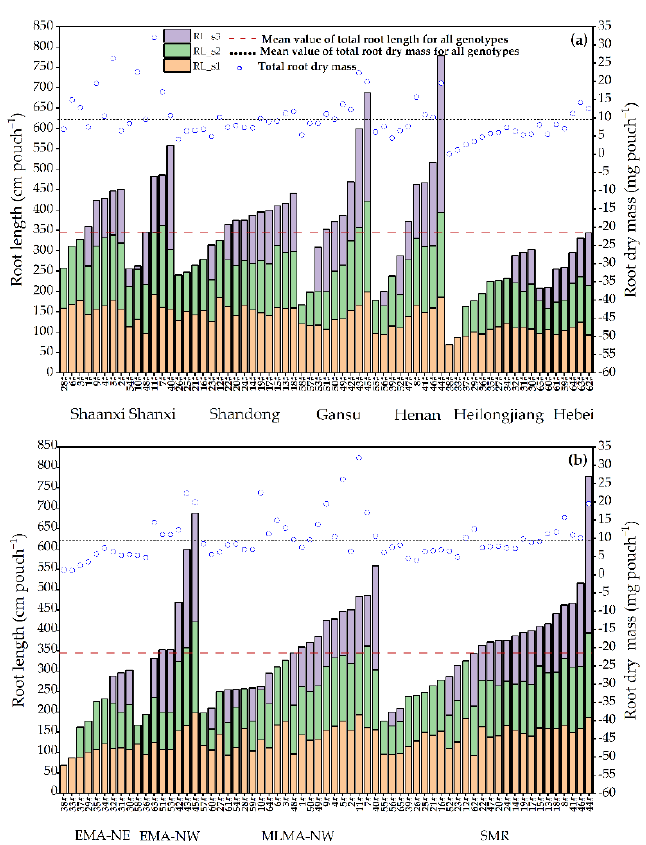
Figure 2. Variation of 65 millet genotypes shown by cumulative histograms: ( a ) root length and root dry mass ordered by seven provinces and ( b ) root length and root dry mass ordered by four ecological regions. Data were plotted from the lowest to the highest total root length (TRL) value; root lengths for the three sections were plotted in three different colors; RL_S1: root length in Section 1 (0–5 cm, orange bars); RL_S2: root length in Section 2 (5–10 cm, green bars); RL_S3: root length in Section 3 (>10 cm, purple bars). The abbreviations of four ecological regions: early maturing area of northeast China (EMA-NE), early maturing area of northwest China (EMA-NW), mid-late maturing region in northwest China (MLMA-NW), summer maturing region (SMR).